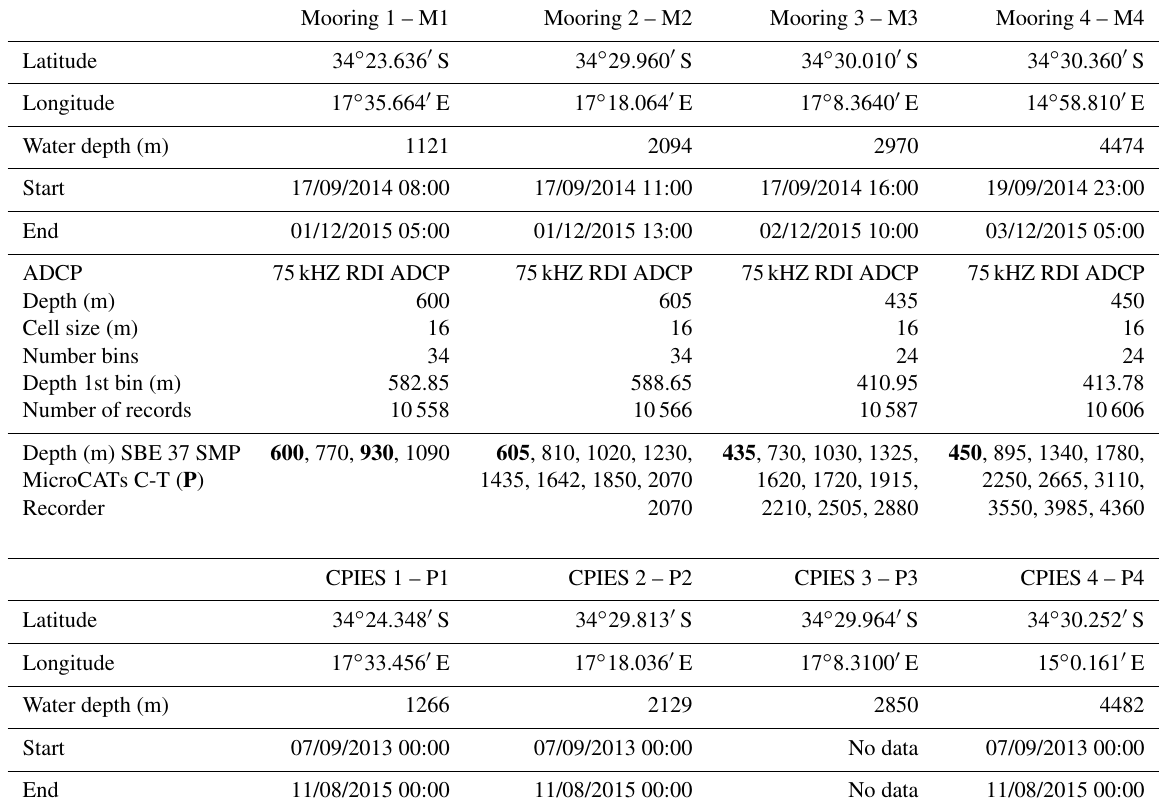
Table 1. Moorings and CPIES characteristics. The date format is dd/mm/yyyy. The bold values represent the depth of the instruments with pressure